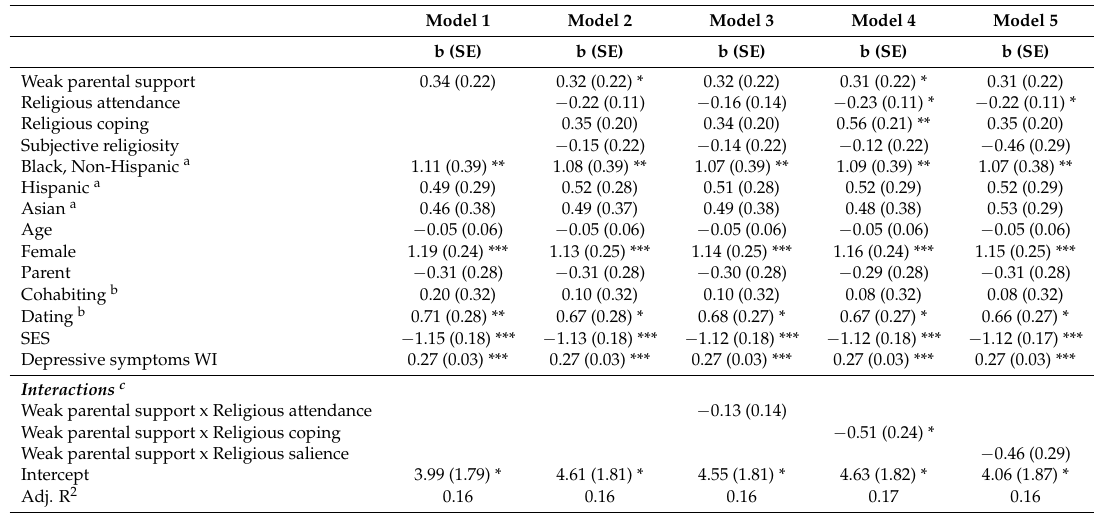
Table 3. Estimated for Weighted Linear Regression Models Predicting Depressive Symptoms, Interracial Relationships (n = 2382), Add Health.